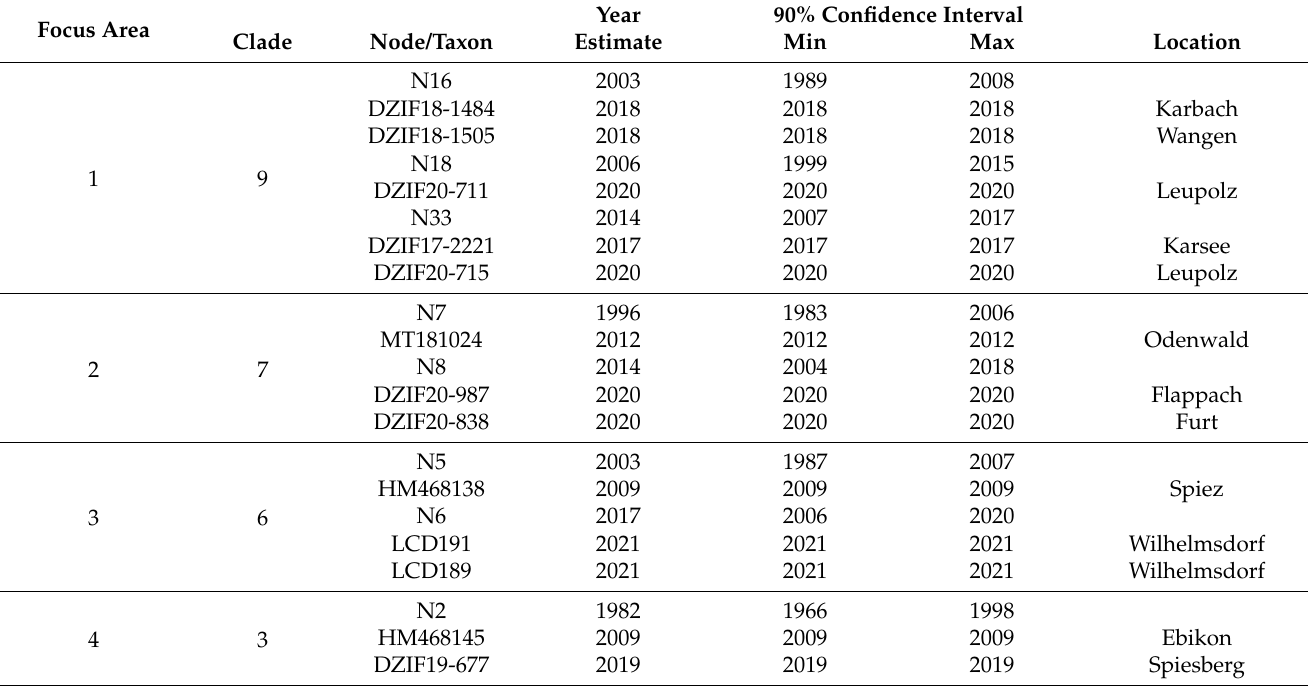
Table 3. Inferred divergence dates for the relevant internal nodes and tips of the Ravensburg focus areas. Node names correspond to annotations depicted in Figure